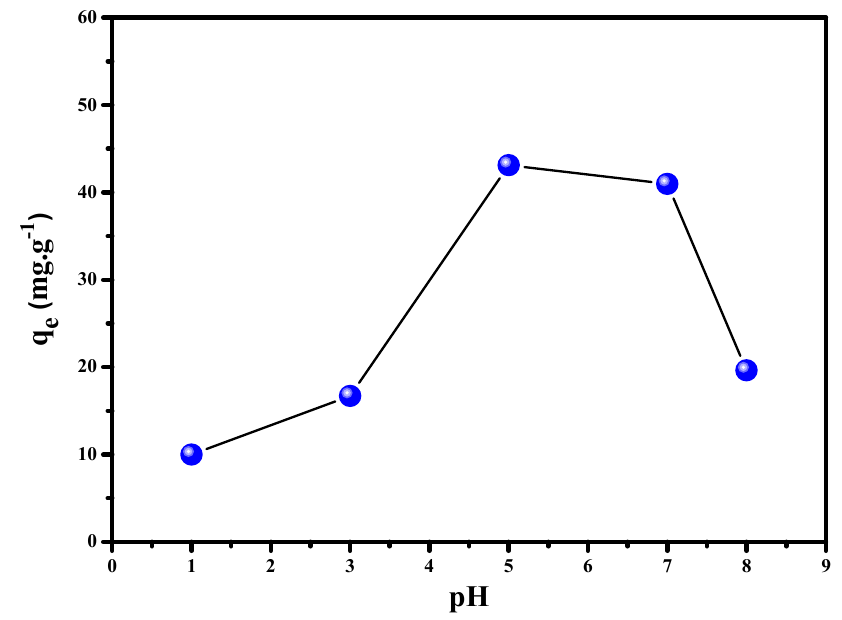
Figure 5. The pH impact on the uptake rate of Cu 2+ metal ions by Zr-G-C 3 N 4 nanomaterial. At lower pH values, more hydrogen protons subsist to protonate active species on Zr-G-C 3 N 4 nanomaterial surfaces and compete with Cu 2+ ions in the suspension, which corroborates previous studies in the literature [57–60]. In addition, according to earlier studies, Cu 2+ ions are only accessible in the divalent state at pH values below 5.0.